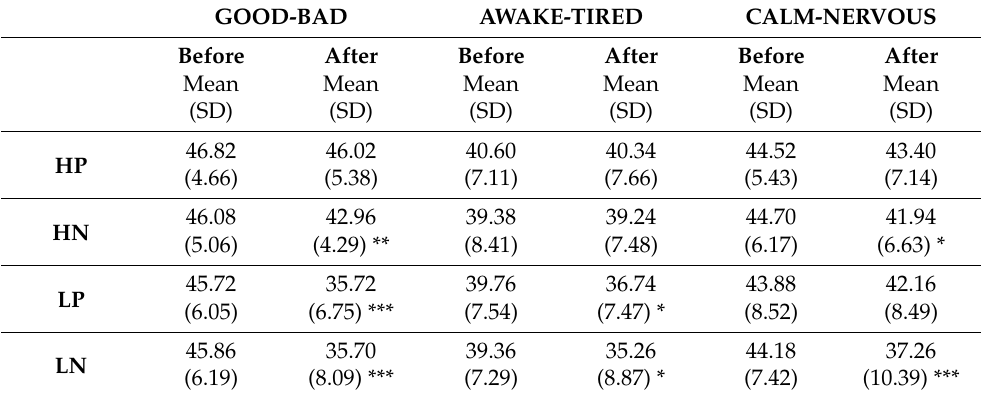
Table 3. Mean and standard deviation (SD, in parenthesis below the mean values) values for each mood dimension before and after the experiment. HP (high arousal positive valence), HN (high arousal negative valence), LP (low arousal positive valence), and LN (low arousal negative valence). Score range: 10 (very bad, very tired, very nervous)–60 (very good, very awake, very calm). Significant differences are indicated with * p < 0.05; ** p < 0.005; *** p <